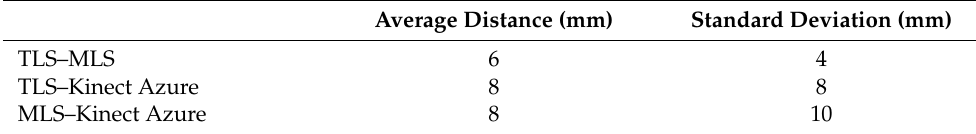
Figure 17. Means and standard deviations of C2C distances between the point clouds: ( a ) TLS vs. MLS, ( b ) TLS vs. Kinect Azure, ( c ) MLS vs. Kinect Azure. Table 3. Mean C2C distance [in mm] and standard deviations [in mm] between point clouds.